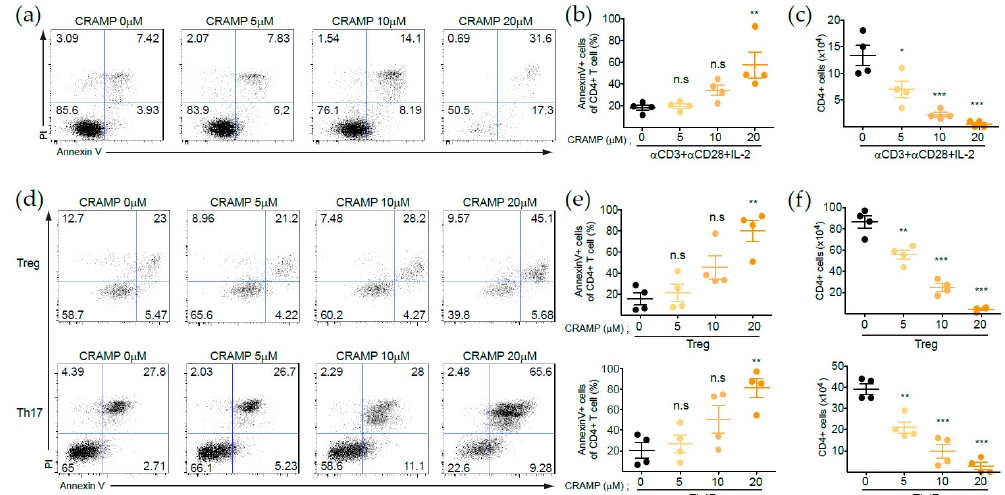
Figure 1. CRAMP induces the apoptosis of CD4 + T cells . ( a – c ) Naïve CD4+ T cells were activated with anti-CD3/CD28 in the presence of various concentrations of CRAMP for three days and subjected to Annexin V/PI staining. Flow cytometry analysis ( a ), frequency of apoptotic cells (Annexin V+ cells) ( b ), and absolute number of live cells ( c ) are indicated ( n = 4). ( d – f ) Naïve CD4+ T cells were differentiated into Tregs and Th17 cells in vitro in the presence of various concentrations of CRAMP for three or five days. Differentiated Tregs and Th17 cells were then subjected for Annexin V/PI staining and analyzed by flow cytometry ( d ). The frequency ( e ) and absolute number ( f ) of live cells are indicated ( n = 4). * p < 0.05, ** p < 0.01, *** p < 0.001, n.s—not significant (one-way ANOVA with post hoc Tukey